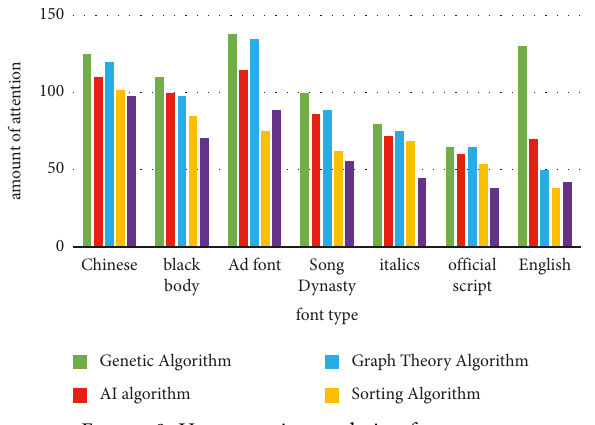
Figure 8: User attention to design font types.